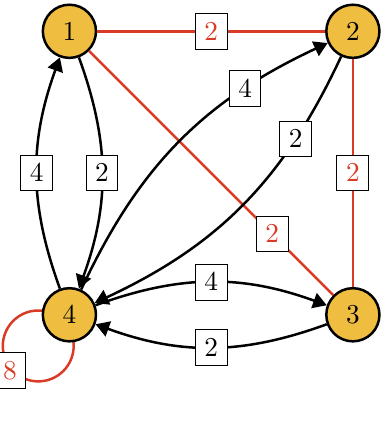
Figure 16 . Quiver diagram for phase S of Q 1 , 1 , 1